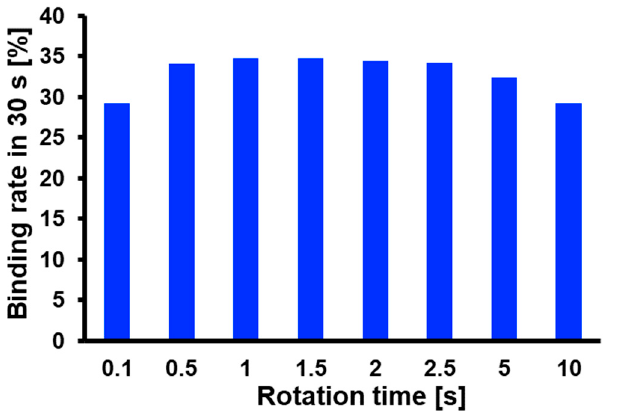
Figure 12. Calculated variation in binding rate after repeating the stopping and re-rotating for 30 s by stopping time in 0.1 s and changing rotation time from 0.1 s to 10 s.